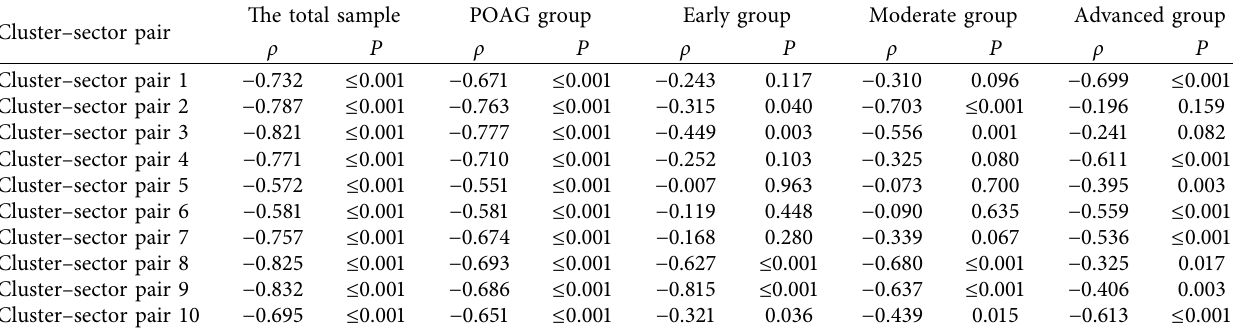
Table 2: Structure–function correlation results between sector pRNFLT and corresponding cluster MD in each group ( P < 0 . 01). Cluster–sector pair